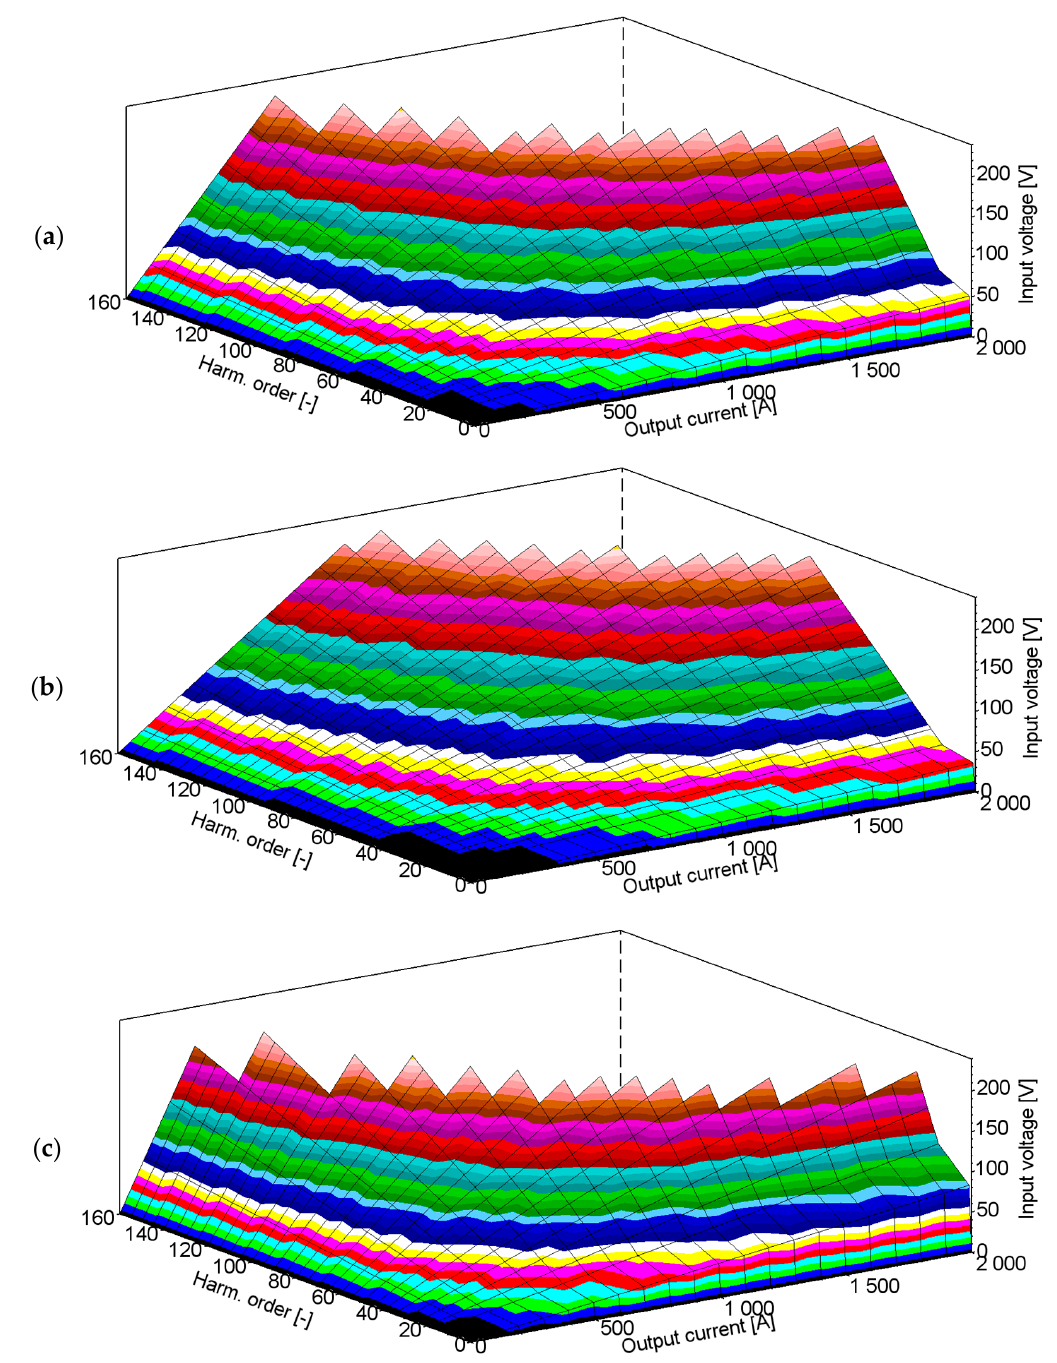
Figure 7. The calculated distorted output current with a given harmonic order for the supplied primary voltage obtained for the parallel connection of the primary winding’s sections and the serial-parallel connection of the secondary winding’s sections: ( a ) R L = 0.3 m Ω ; L L = 3 μ H, ( b ) R L = 0.3 m Ω ; L L = 1.5 μ H, ( c ) R L = 0.3 m Ω ; L L = 6 μ H.